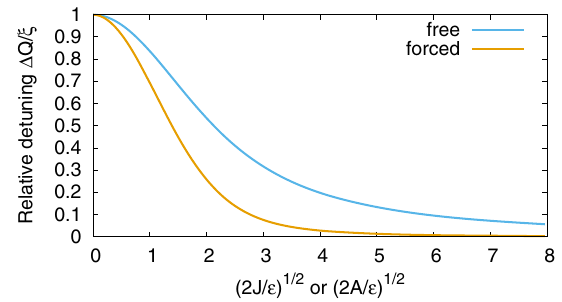
FIG. 2. Beam-beam amplitude detuning for free and forced oscillations in one dimension, Eqs. (15) and (18). The horizontal axis represents the oscillation amplitude normalized to the beam